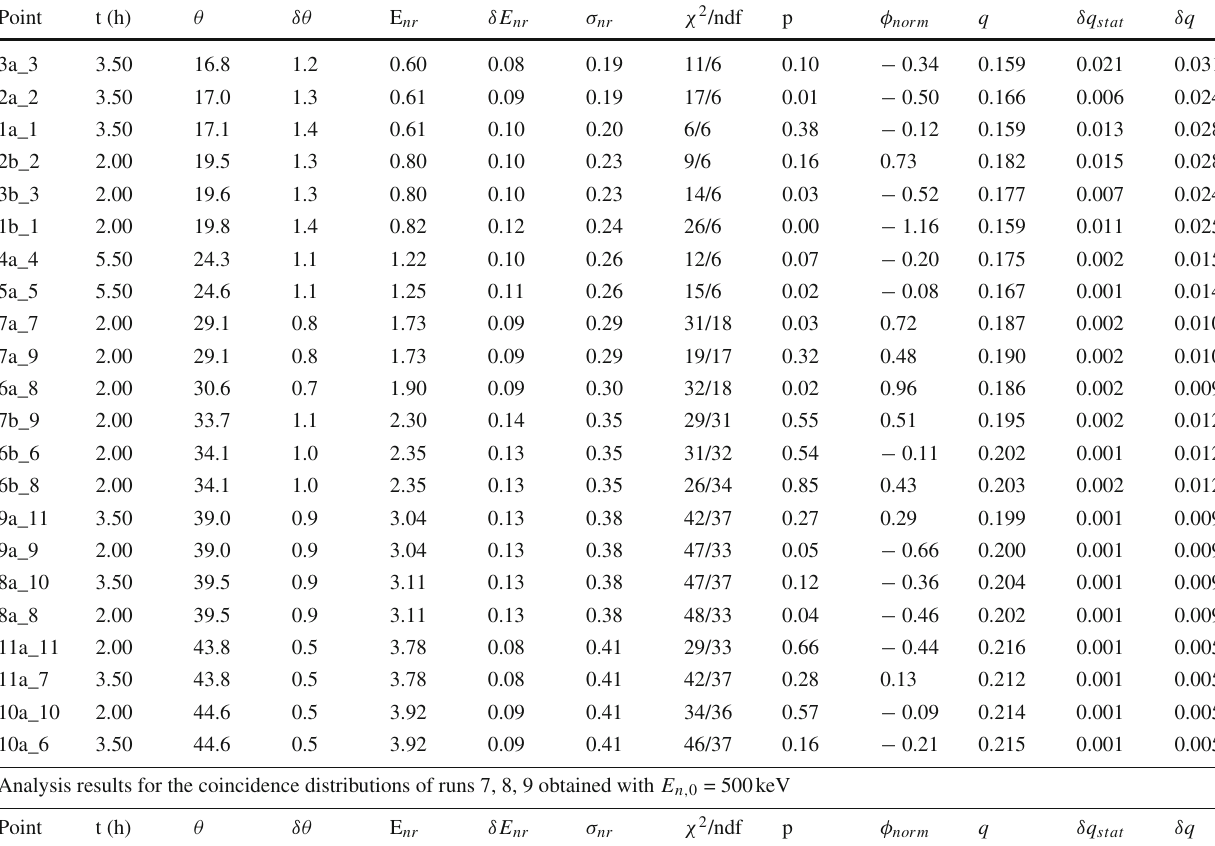
Table 6 Analysis results for the runs 7, 8, 9 (a) and 10, 11 (b). The description of the columns is identical to the one in Tab. 5